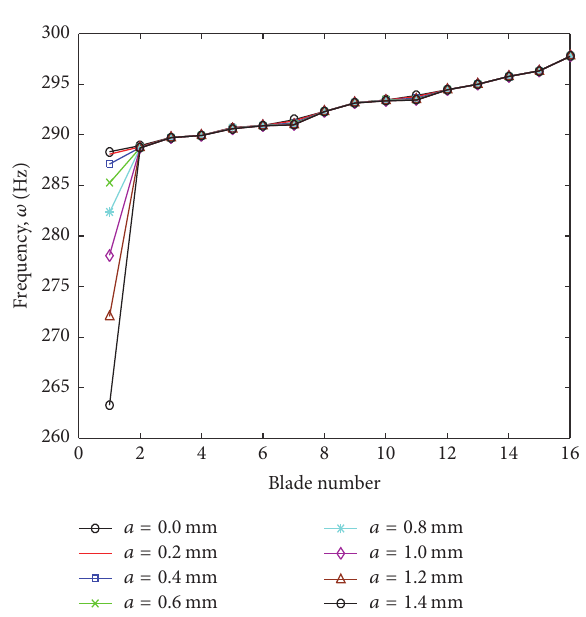
Figure 10: Natural frequencies of MRBs under different 𝑎